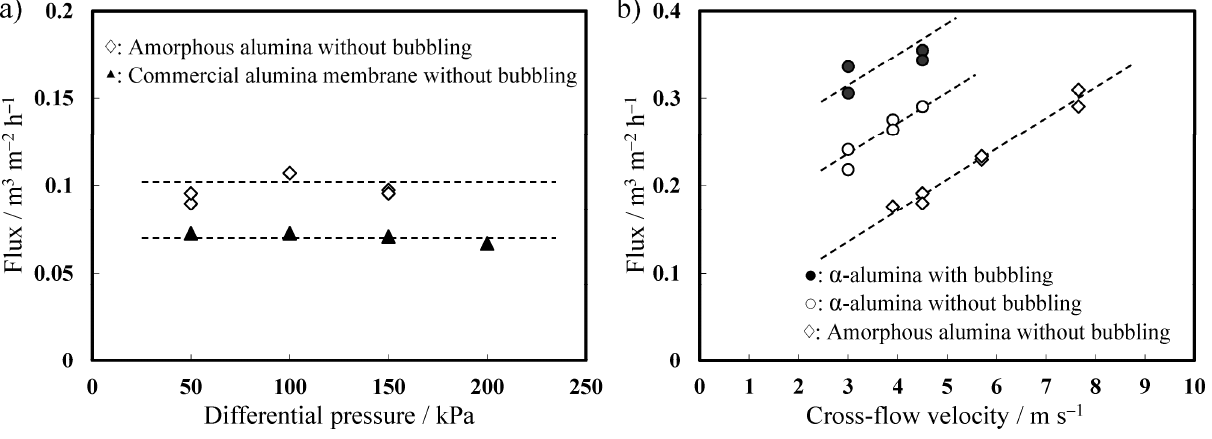
Figure 10. Relationship between the flux and ( a ) differential pressure and ( b ) cross-flow velocity of alumina membranes formed by anodizing in 0.2 mol·dm − 3 phosphoric acid at 185 V when compared with those of commercially available alumina